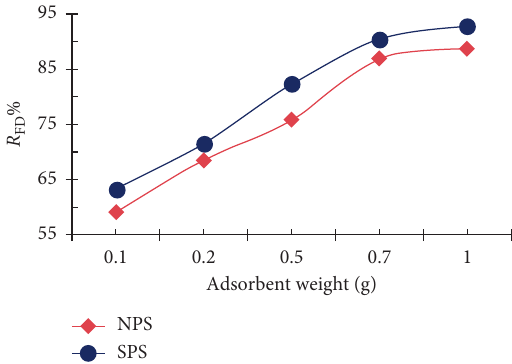
Figure 4: Effect of the initial concentration on the quantity of FD removal by NPS and SPS (1g adsorbent dosage; 50 ml solution volume; 3 h contact time; and 25 ° C temperature).